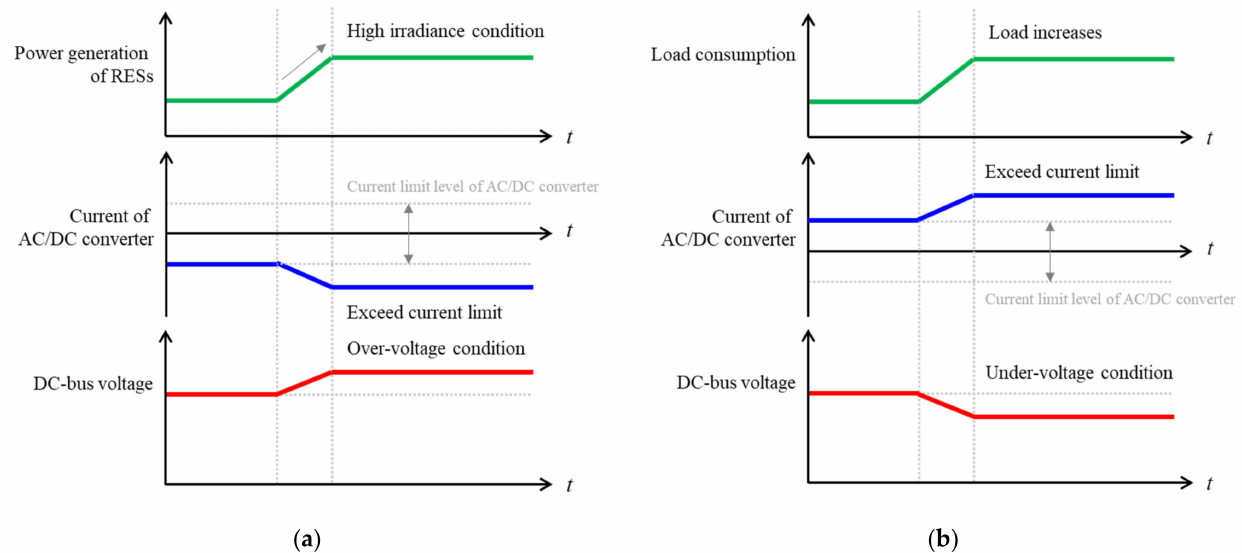
Figure 2. Over- and undervoltage fault conditions of DC bus voltage in DC microgrids: ( a ) Over- voltage fault condition, ( b ) Under-voltage fault